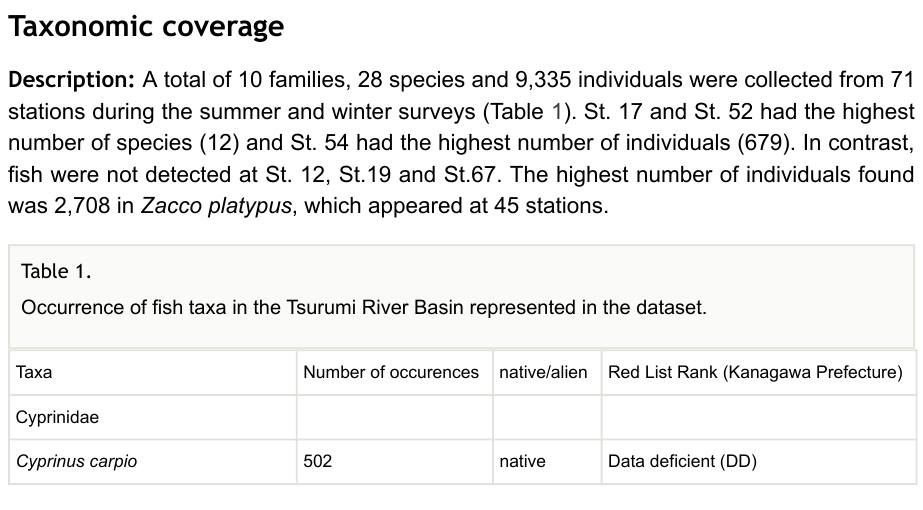
Description: Surveys were conducted at 71 sites in the Tsurumi River Basin during summers and winters, focusing on river channels that have been straightened or converted to concrete channels due to urbanisation.